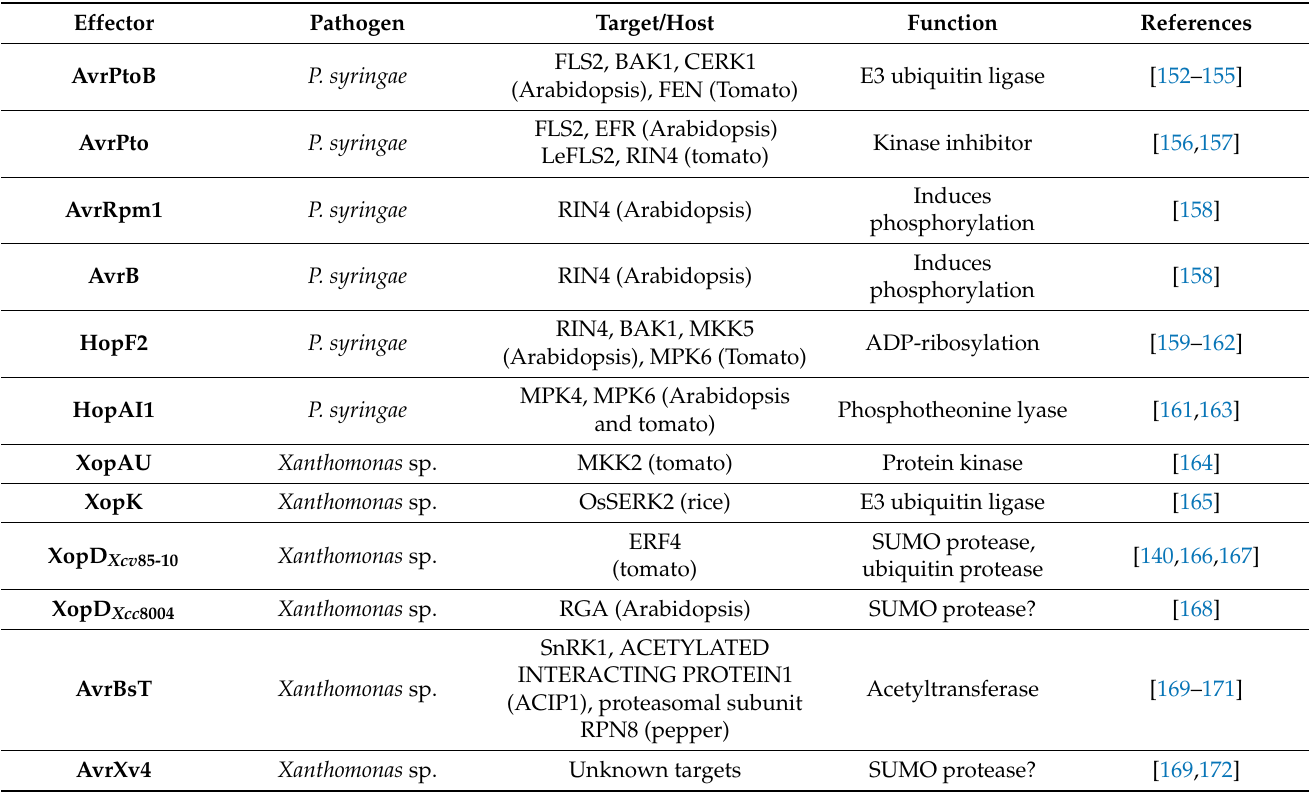
Table 1. Effector examples which regulate host PTM